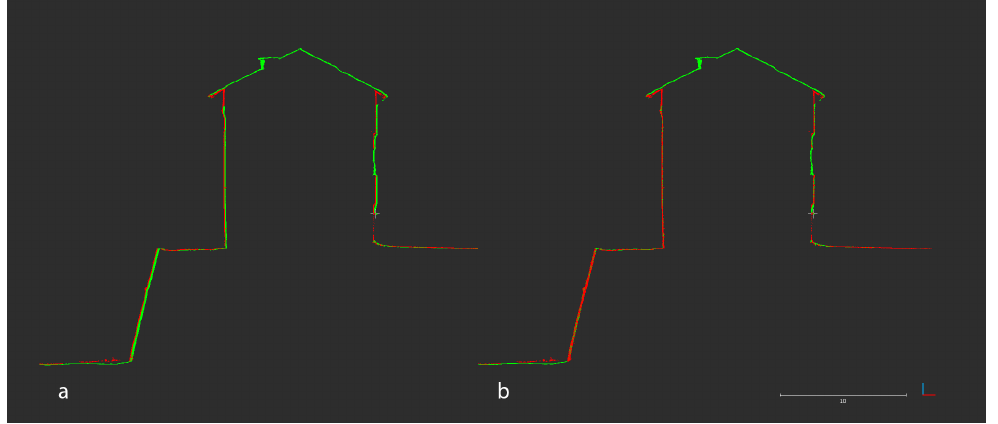
Figure 19. Profile 1 ICP alignment. P1 (green) aligned with SX10 data (red): ( a ) before the alignment; ( b ) af-ter the alignment.